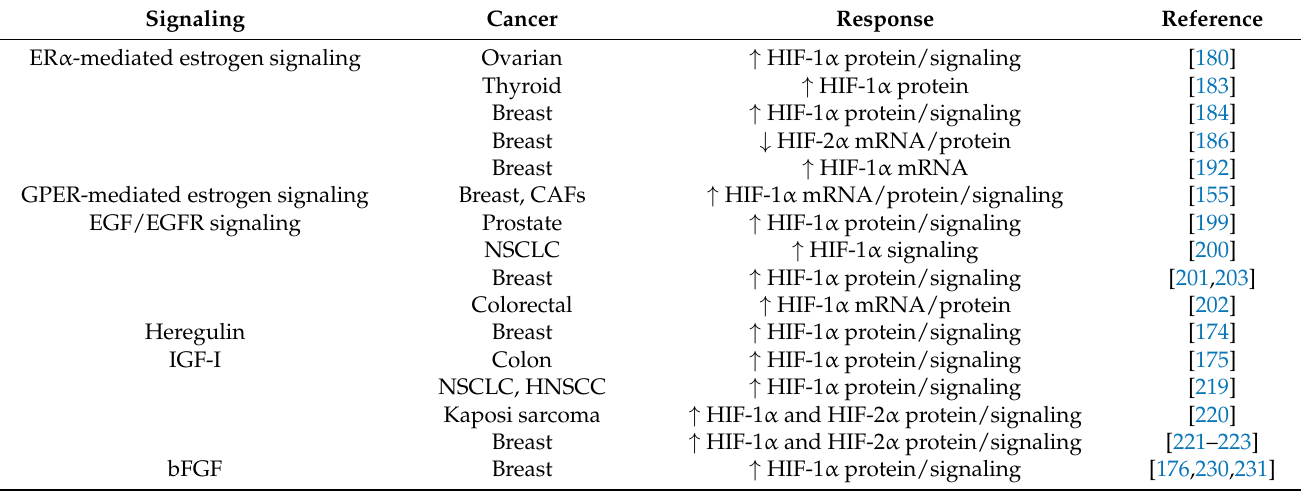
Table 1. Hormone and GF-dependent regulation of HIF expression/signaling ( ↑ is increase, ↓ is decrease). Signaling Cancer